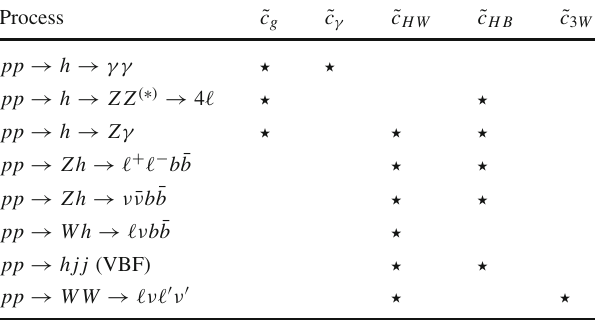
Table 1 List of LHC processes investigated in this work, presented togetherwiththeirdependence,indicatedbyastar,ontheEFToperators under consideration Process ˜ c